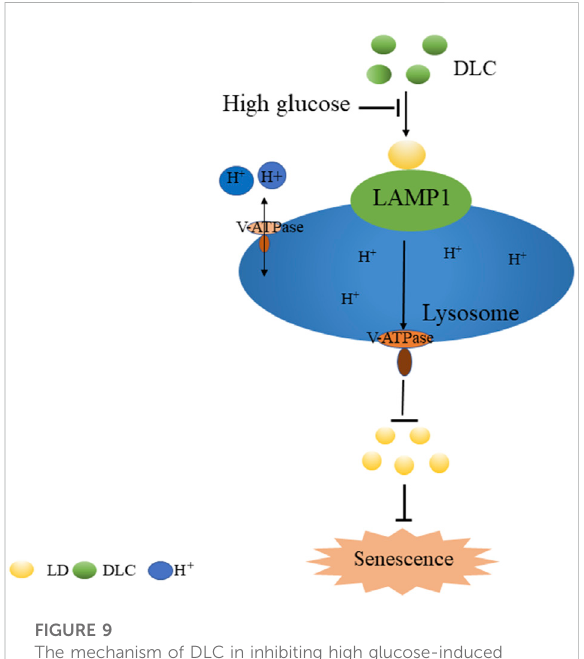
FIGURE 9 The mechanism of DLC in inhibiting high glucose-induced endothelial cell